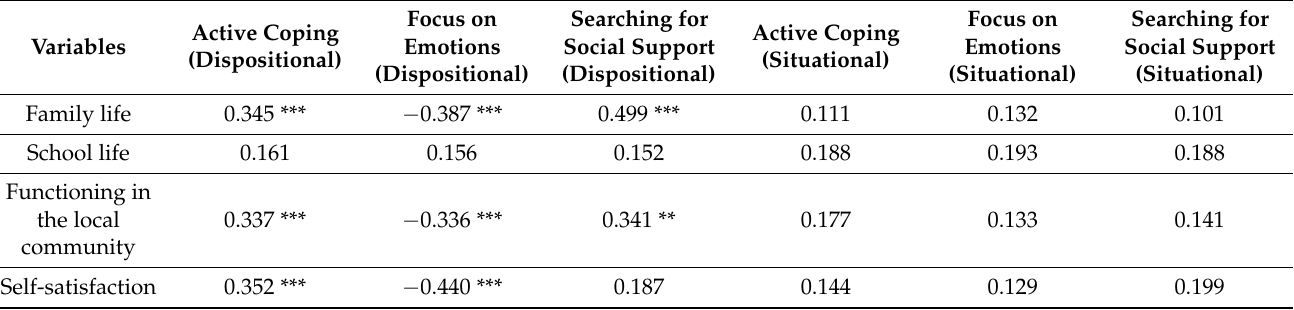
Table 3. Pearson’s r correlations between the variables: quality of life and coping with fear. Active Variables